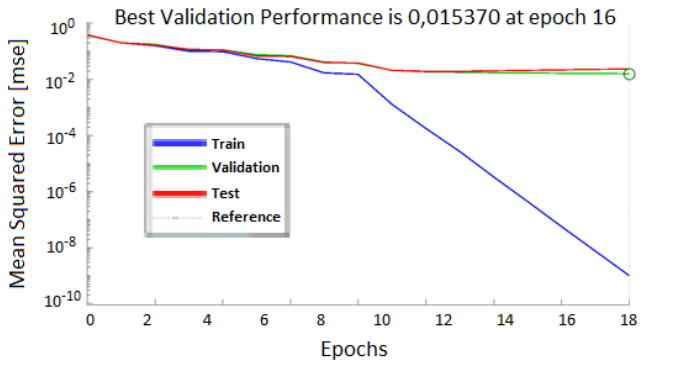
Figure 17. NET2_STATE neural network training efficiency.